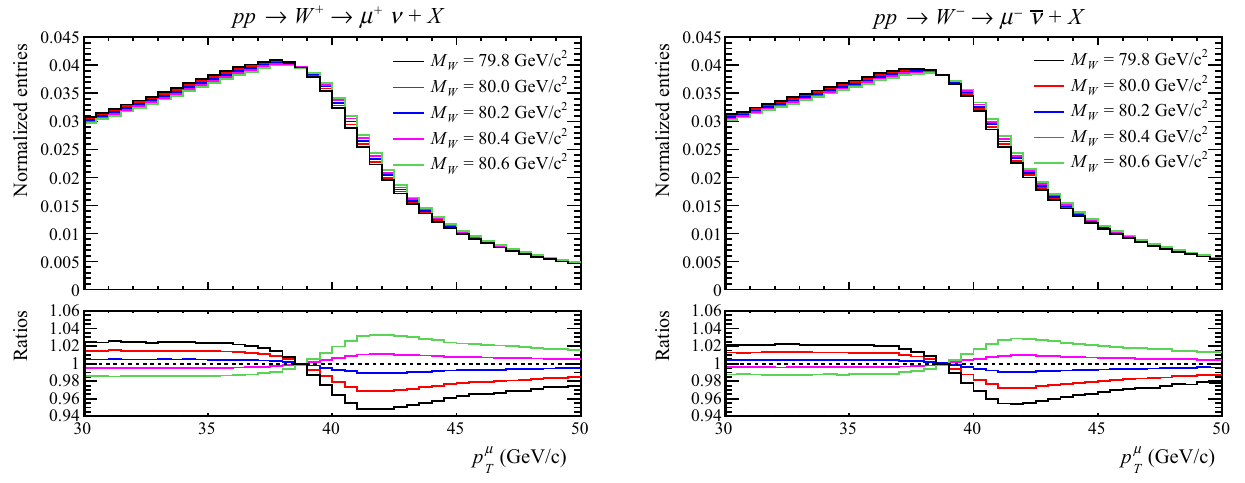
μ Fig. 1 The simulated muon p distributions in W → μν decays (left W + , right W − ) with five different M W hypotheses. The ratios are with T respect to the prediction with M W = 80 . 3GeV/c